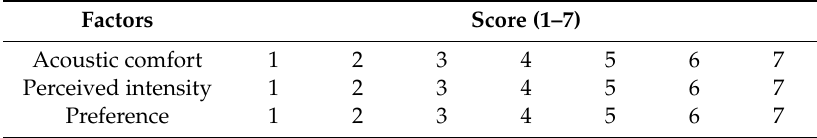
Table 4. Factors of soundscape perception evaluations and scores from 1 to 7.